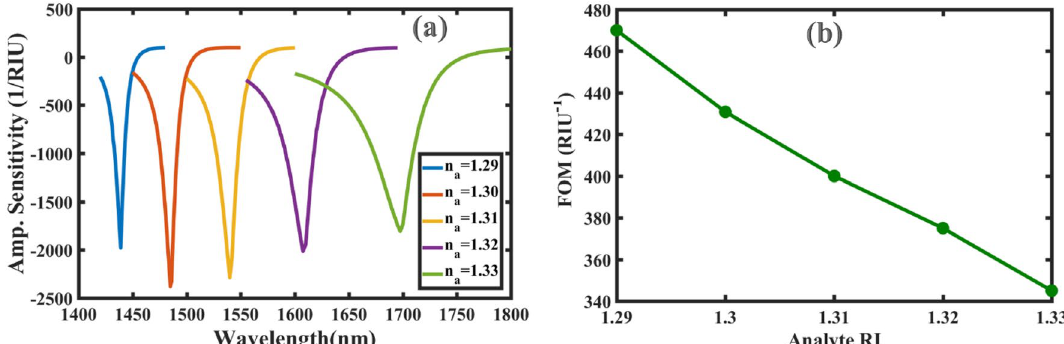
Figure 7. ( a ) Amplitude sensitivity of the proposed SPR sensor for different analyte RIs; and ( b ) the calculated values of FOM for the analyte RIs from 1.29 to